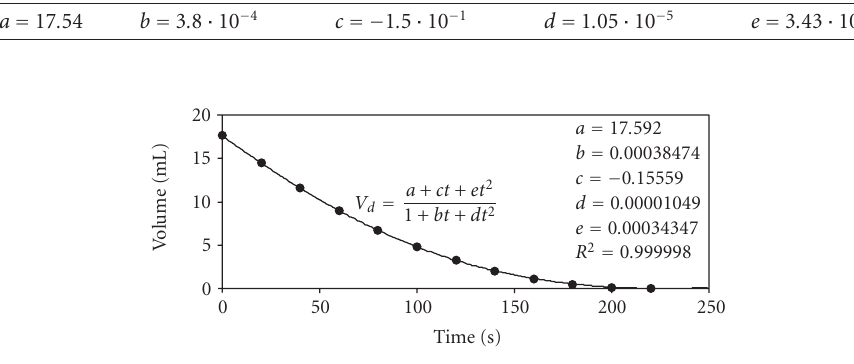
Table 3.4. Coe ffi cients of (3.7) for the drainage process.